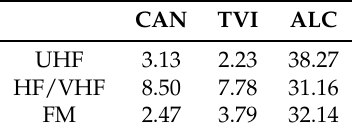
Table 4. Execution times in minutes for 500 iterations for every PSO method and